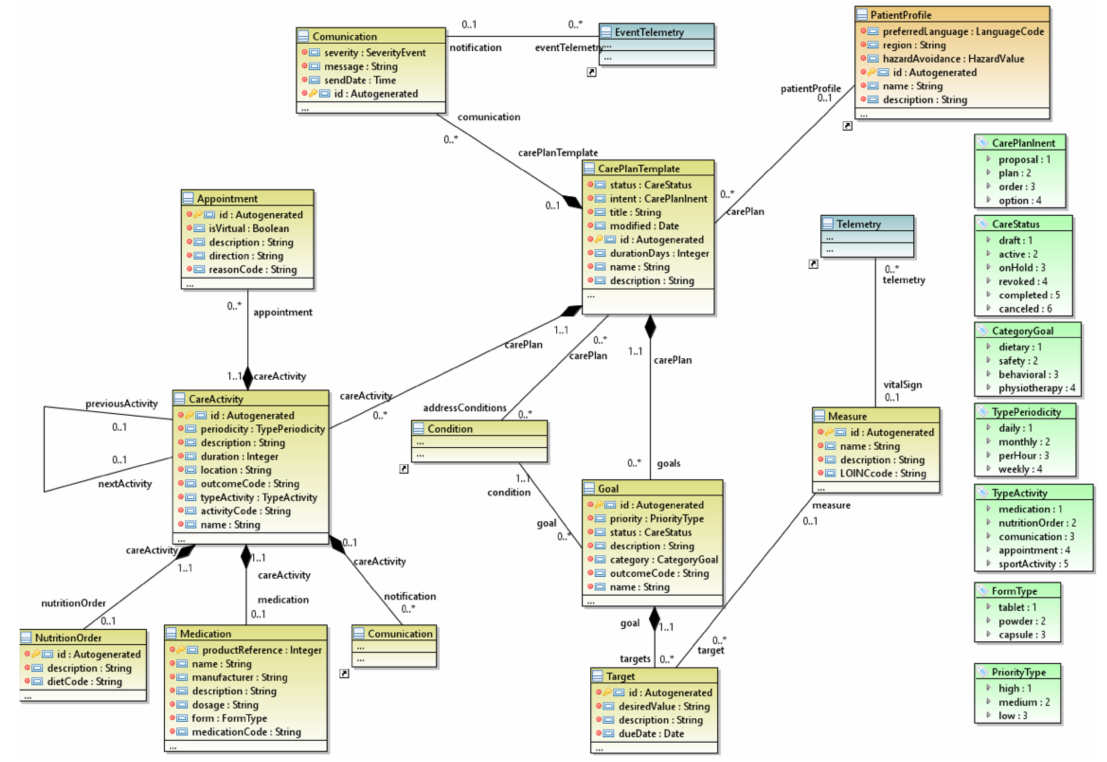
Figure 5. The healthcare